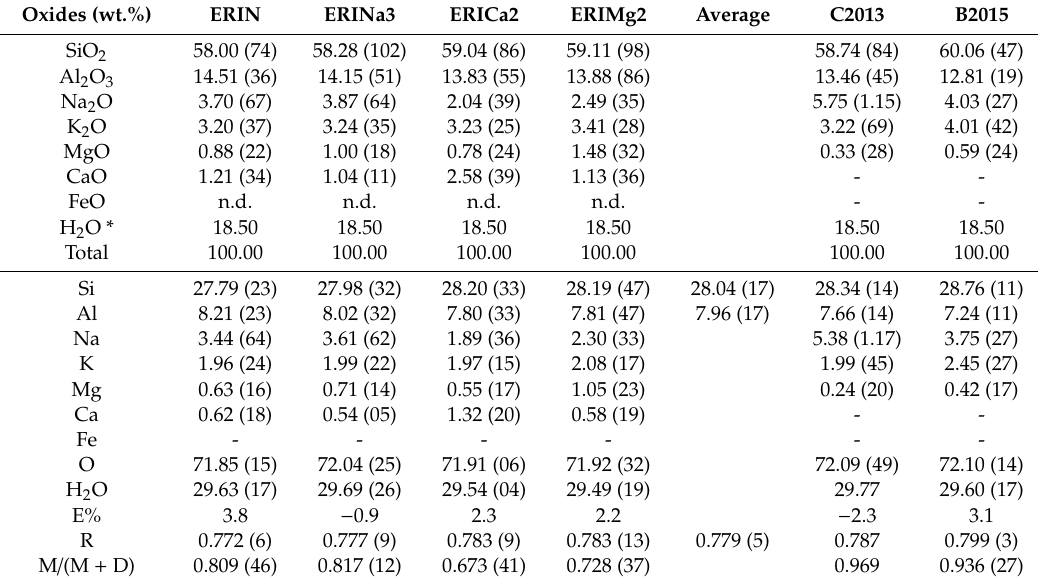
Table 1. SEM-EDX chemical analyses of the both pristine and ion-exchanged erionite fibers. Reference data: (C2013) [37] and (B2015) [57] for erionite-Na are reported for comparison purposes. Oxides